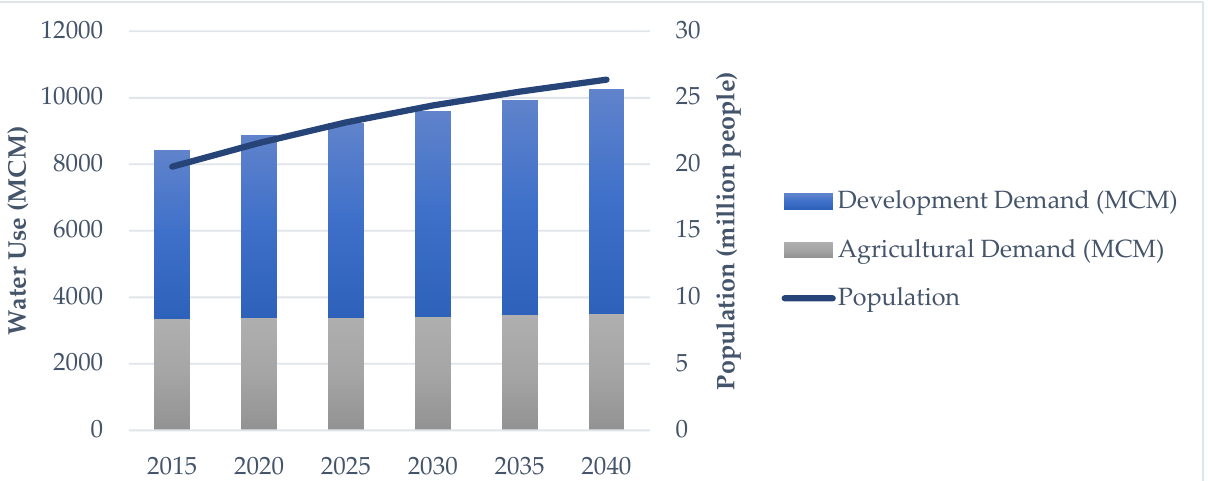
Figure 4. Total Annual Demand Projections and Potential Water Needed by Water Supply Planning Regions. Note: Two regions, SR-West and NFRWSP have water projections to 2035 only. Linear extrapolations of water use are applied to project water demands to 2040. Source: development wa- ter demands (i.e., PS, DSS, CII, L/R, and PG) comes from the 2020 Annual Status Report on Regional